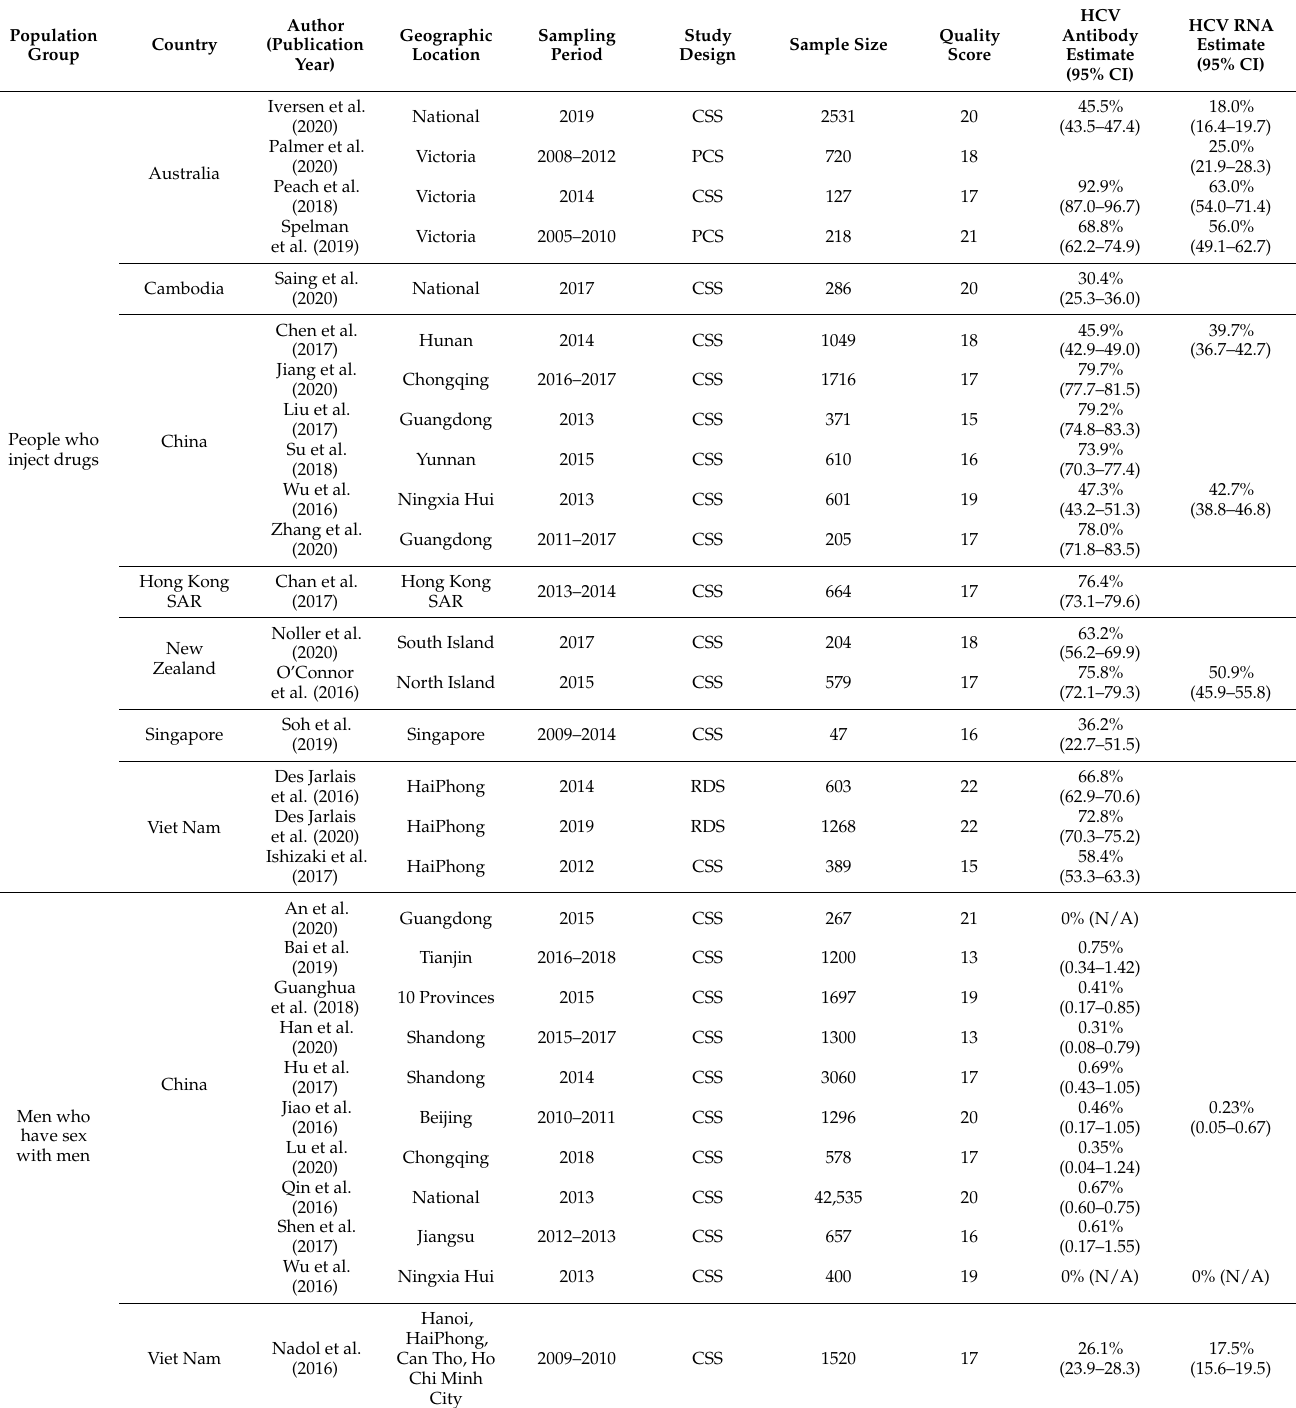
Table A3. Estimates for the prevalence of HCV antibodies (n = 43) and HCV RNA (n = 14) among key population